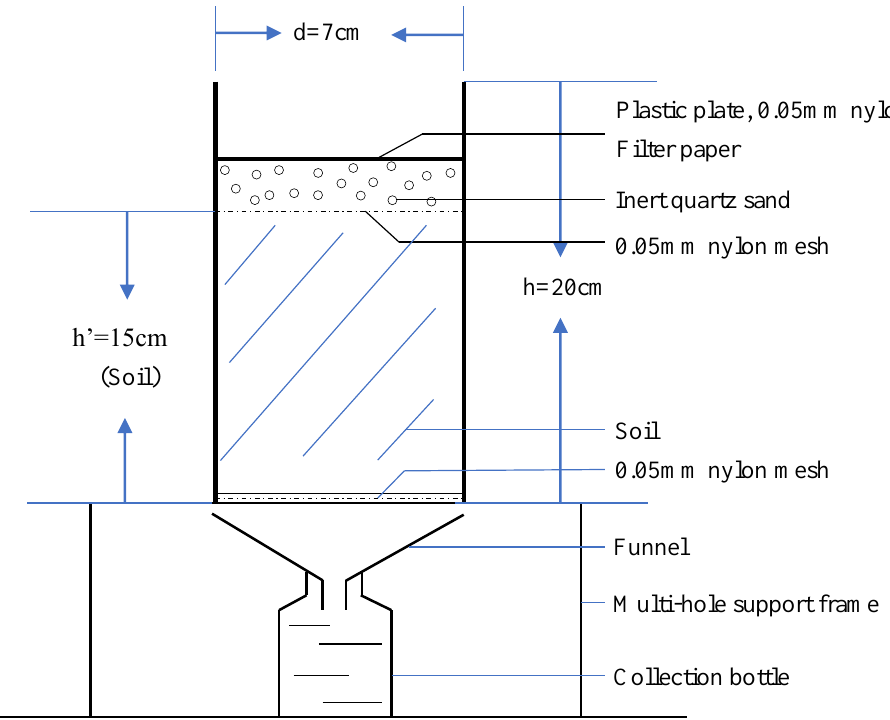
Figure 1. Schematic diagram of the constructed soil column.